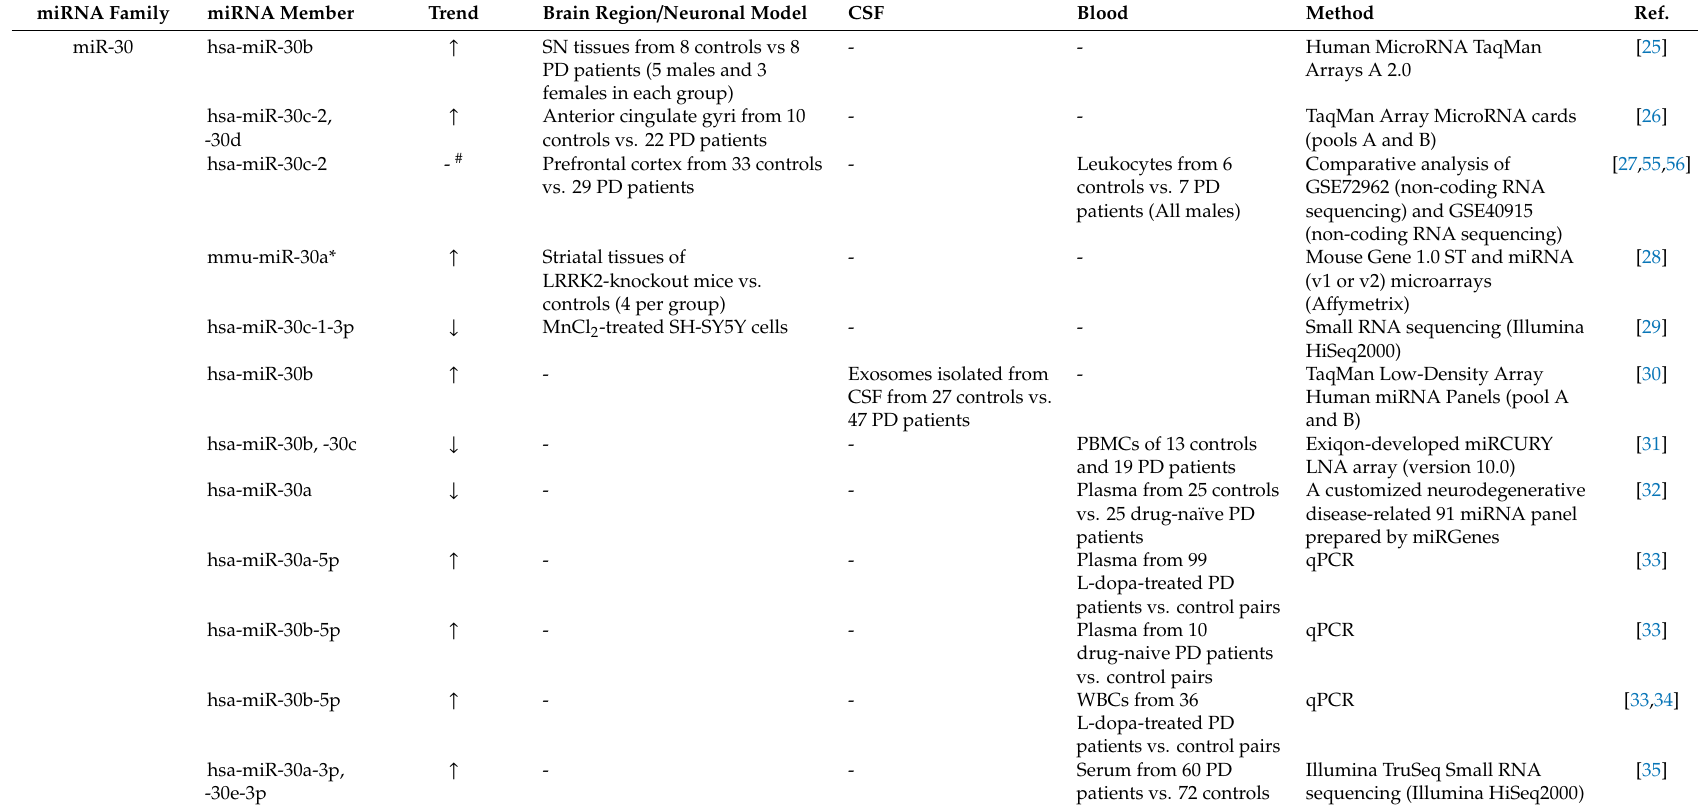
Table 2. Summary of 15 miRNAs reported to be dysregulated in the brain / neuronal model(s), cerebrospinal fluid (CSF) and blood. miRNA Family